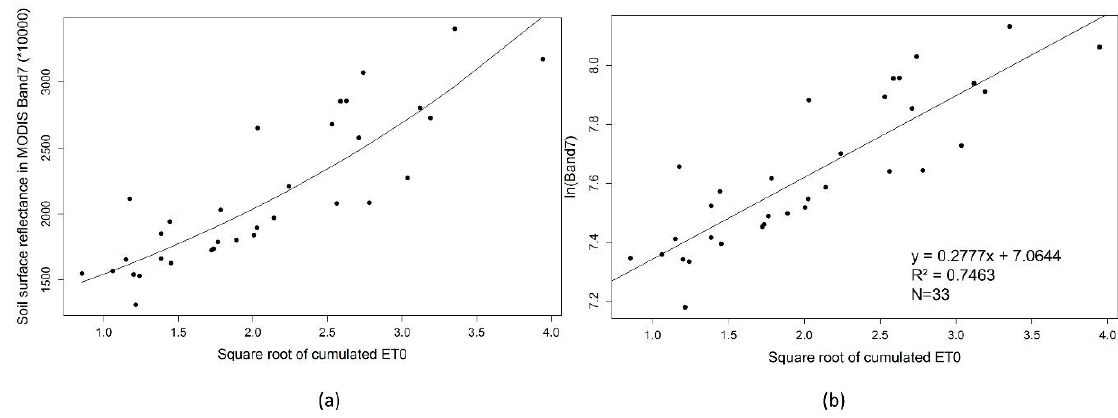
Figure 5. Correlation between soil surface reflectance in water sensitive band (MODIS band 7) and square root of cumulated 𝐶𝐸𝑇 at one pixel (87.909109°W, 40.514948°N). 0 ( a ) Exponential relationship; ( b ) Linear relationship after natural logarithm transform.